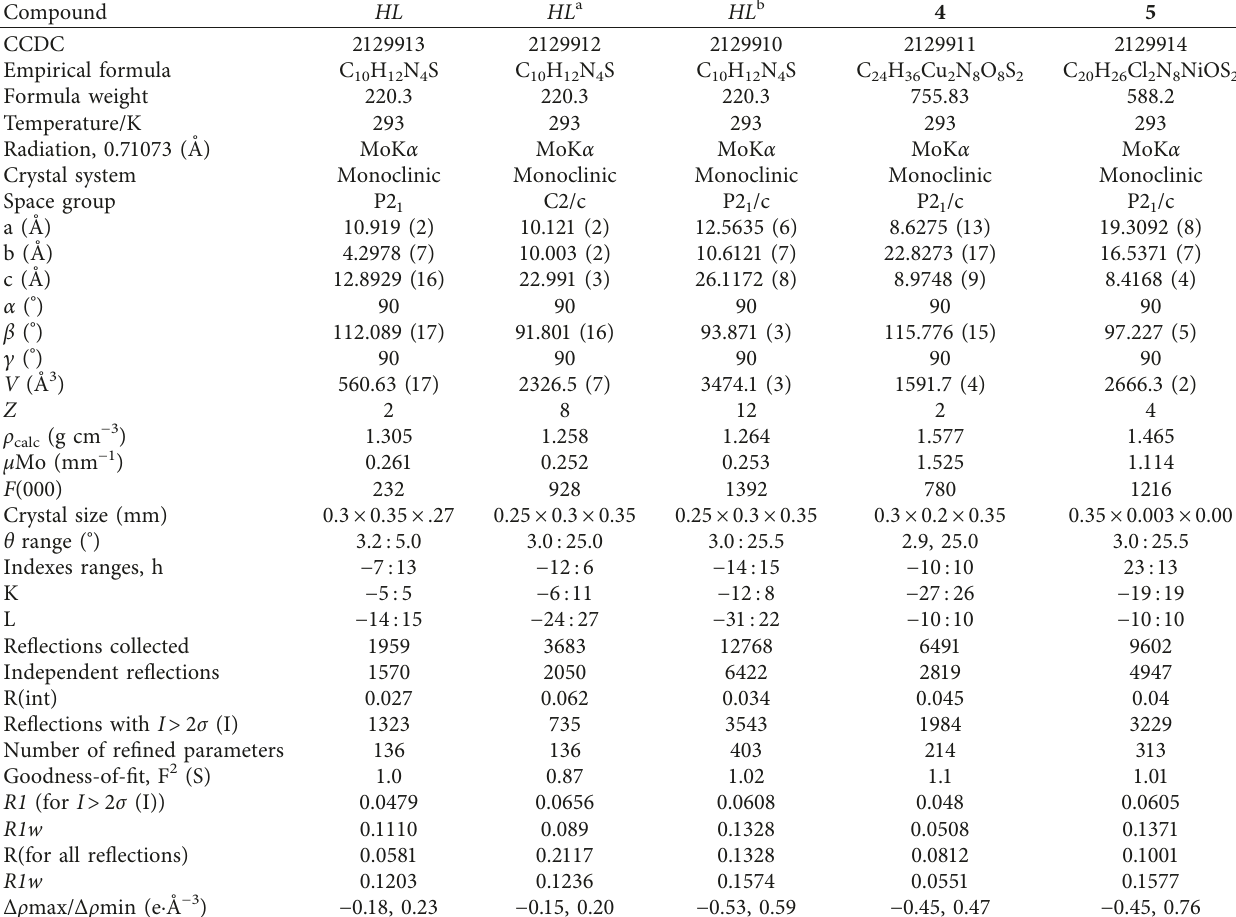
Table 1: Crystal and structure refinement data for HL , HL a , HL b , 4 , and 5 .